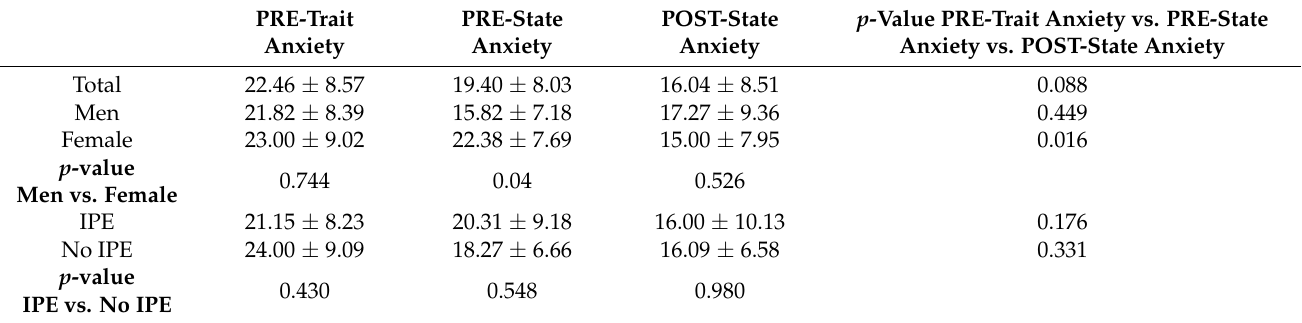
Table 1. Anxiety (pre- and post-intervention) categorized by gender and by personal protective equipment